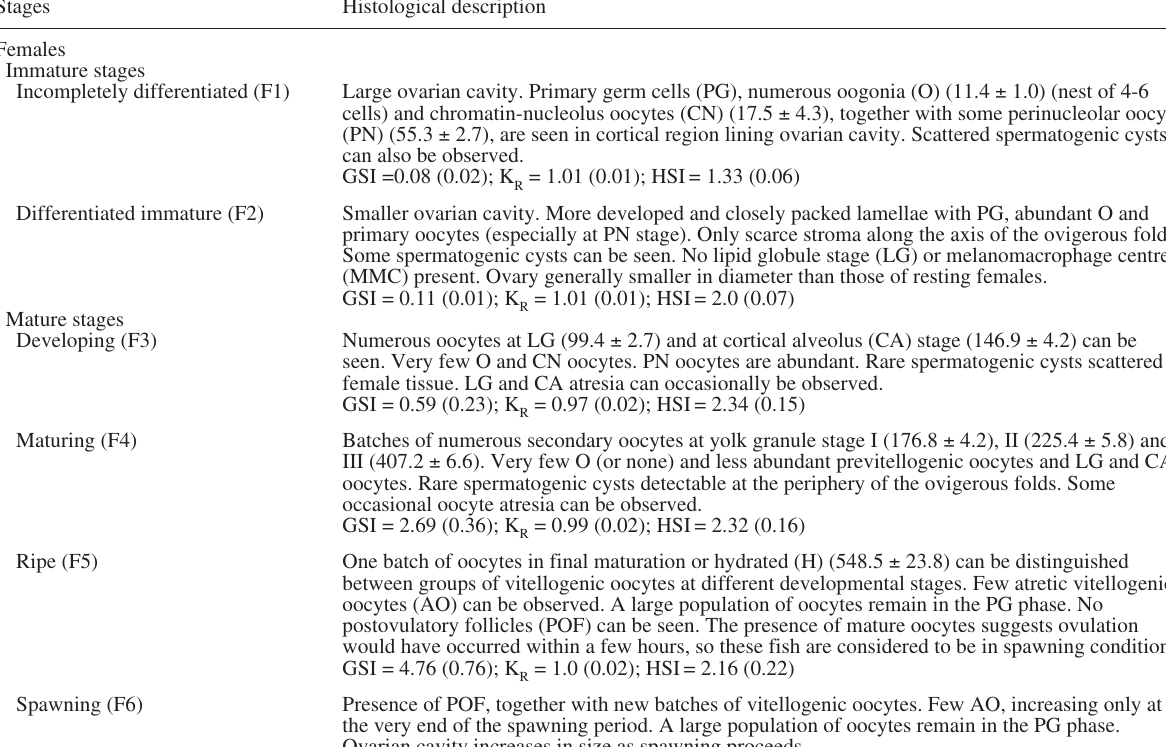
Table 1. – Microscopic description of developmental gonad stages for females, transitionals and males of Epinephelus marginatus . Mean diameter of gametogenic stages ( m m) and gonadosomatic (GSI), hepatosomatic (HSI) and Le Cren (K ) indexes for the different gonad stages R ( ± standard error) are